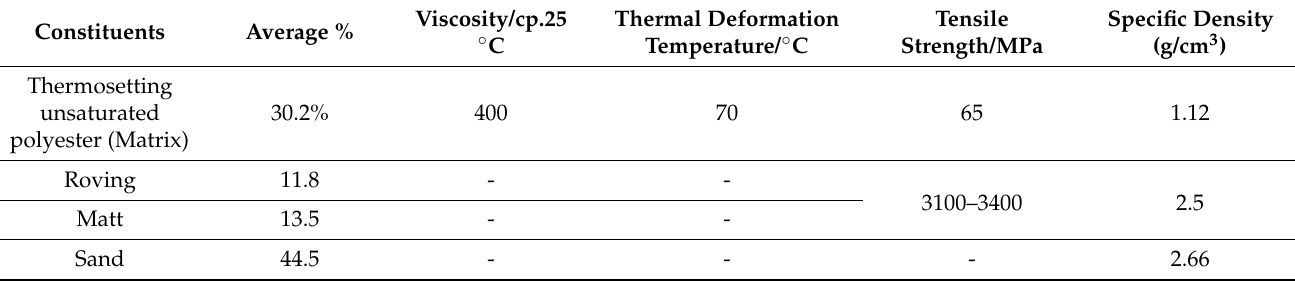
Figure 4. Schematic drawing of GRP cross-section. Table 1. Composition of GFR pipes [2].